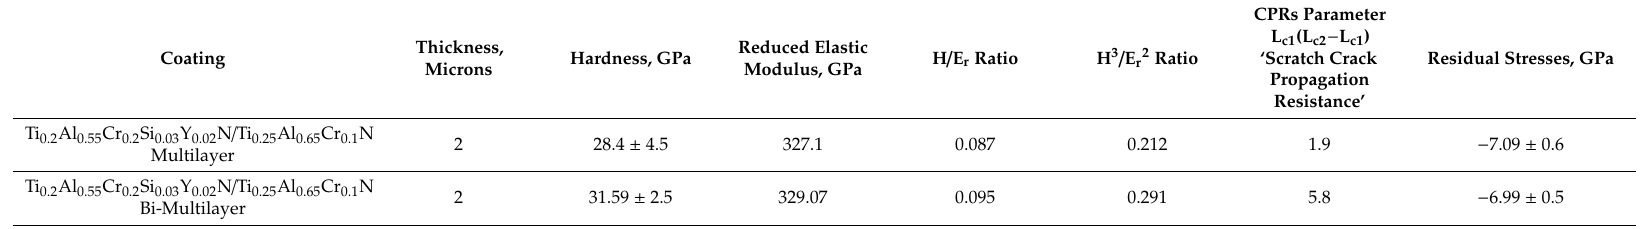
Table 1. Micro-mechanical properties of the studied coatings